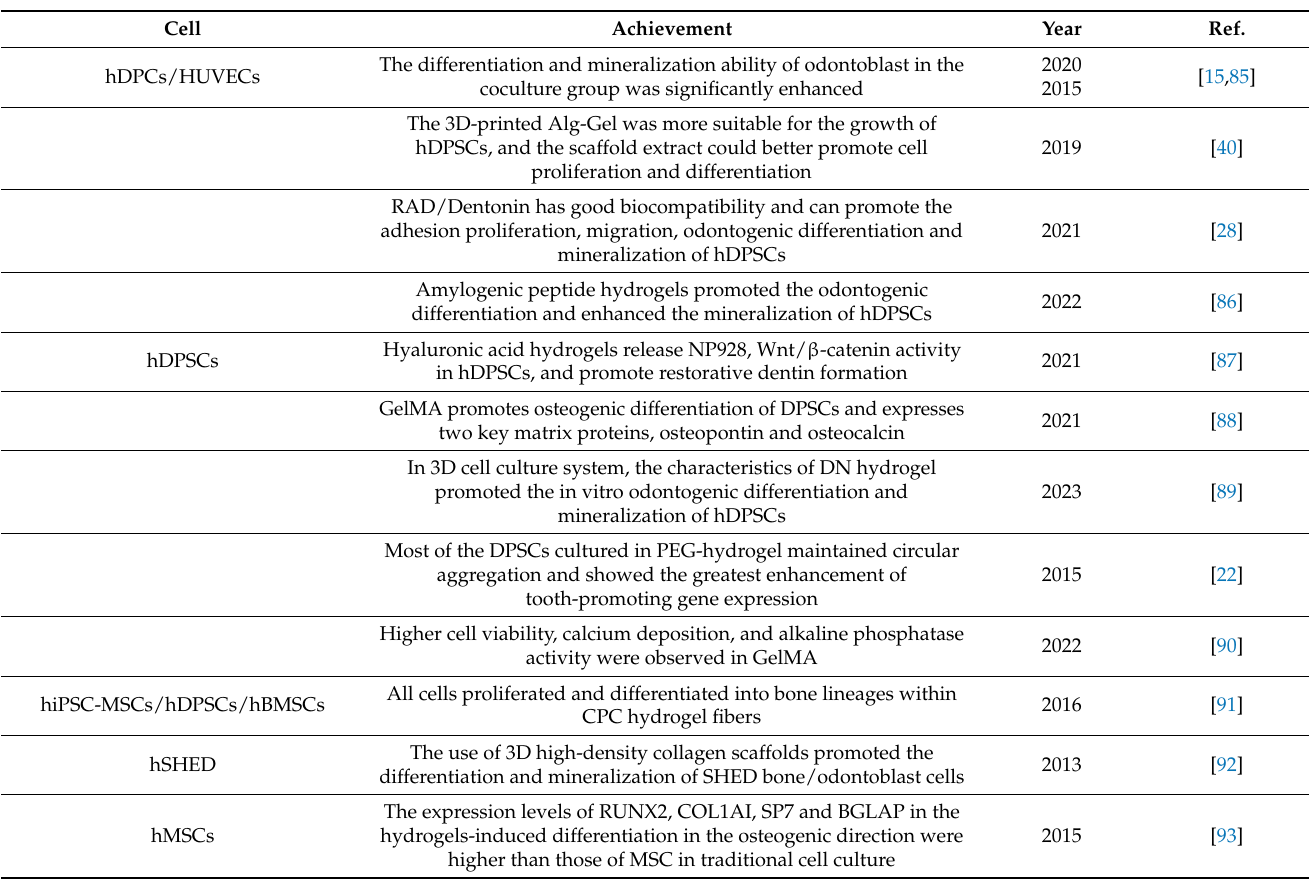
Table 3. Application of hydrogel in mineralization of odontogenic stem